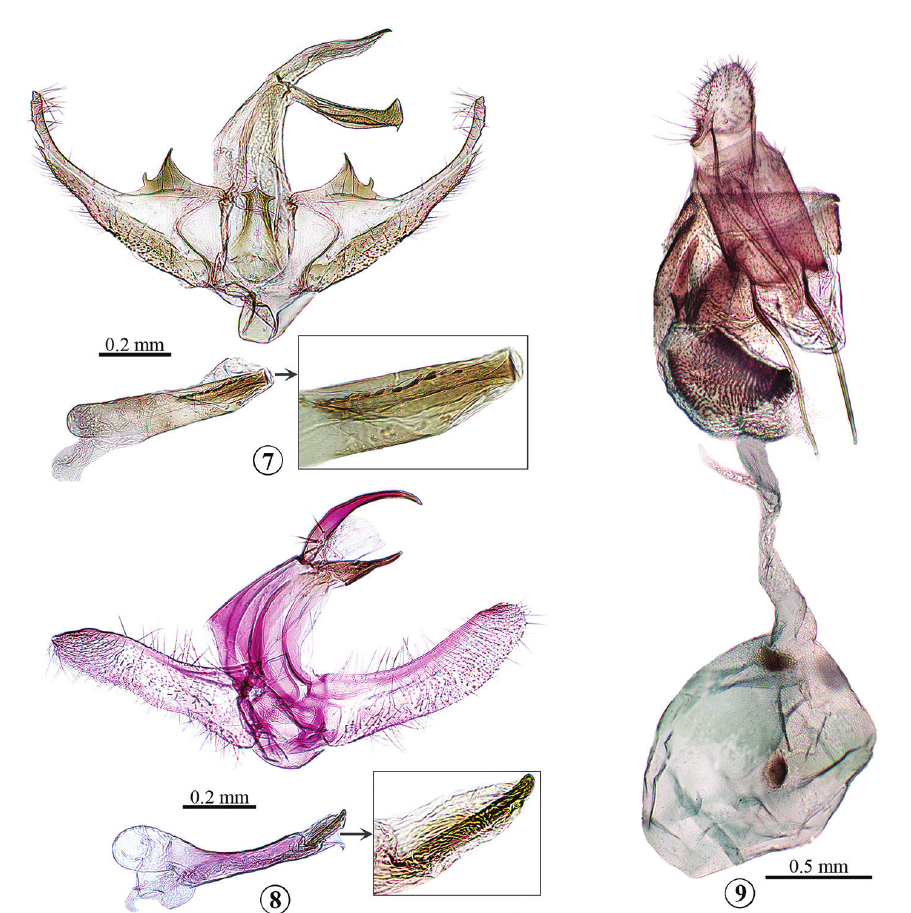
Figures 7–9. Genitalia of Glaucocharis species. 7 G. sperlingi sp. n., male, holotype 8 G. nussi sp. n., male, holotype 9 G. castaneus Song & Chen, female. Paratype , 1 ♂ , with same locality as holotype and collected on 10.viii.2012, prep. gen. WD16100